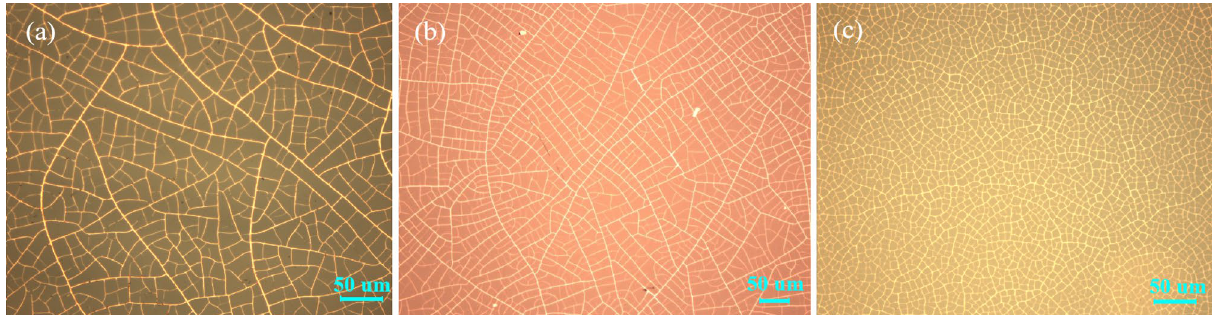
Figure 4. Optical microscope images of copper network films with different coating speeds: ( a ) 1500 r/min, ( b ) 2000 r/min, ( c ) 2400 Microstructure of copper network film.